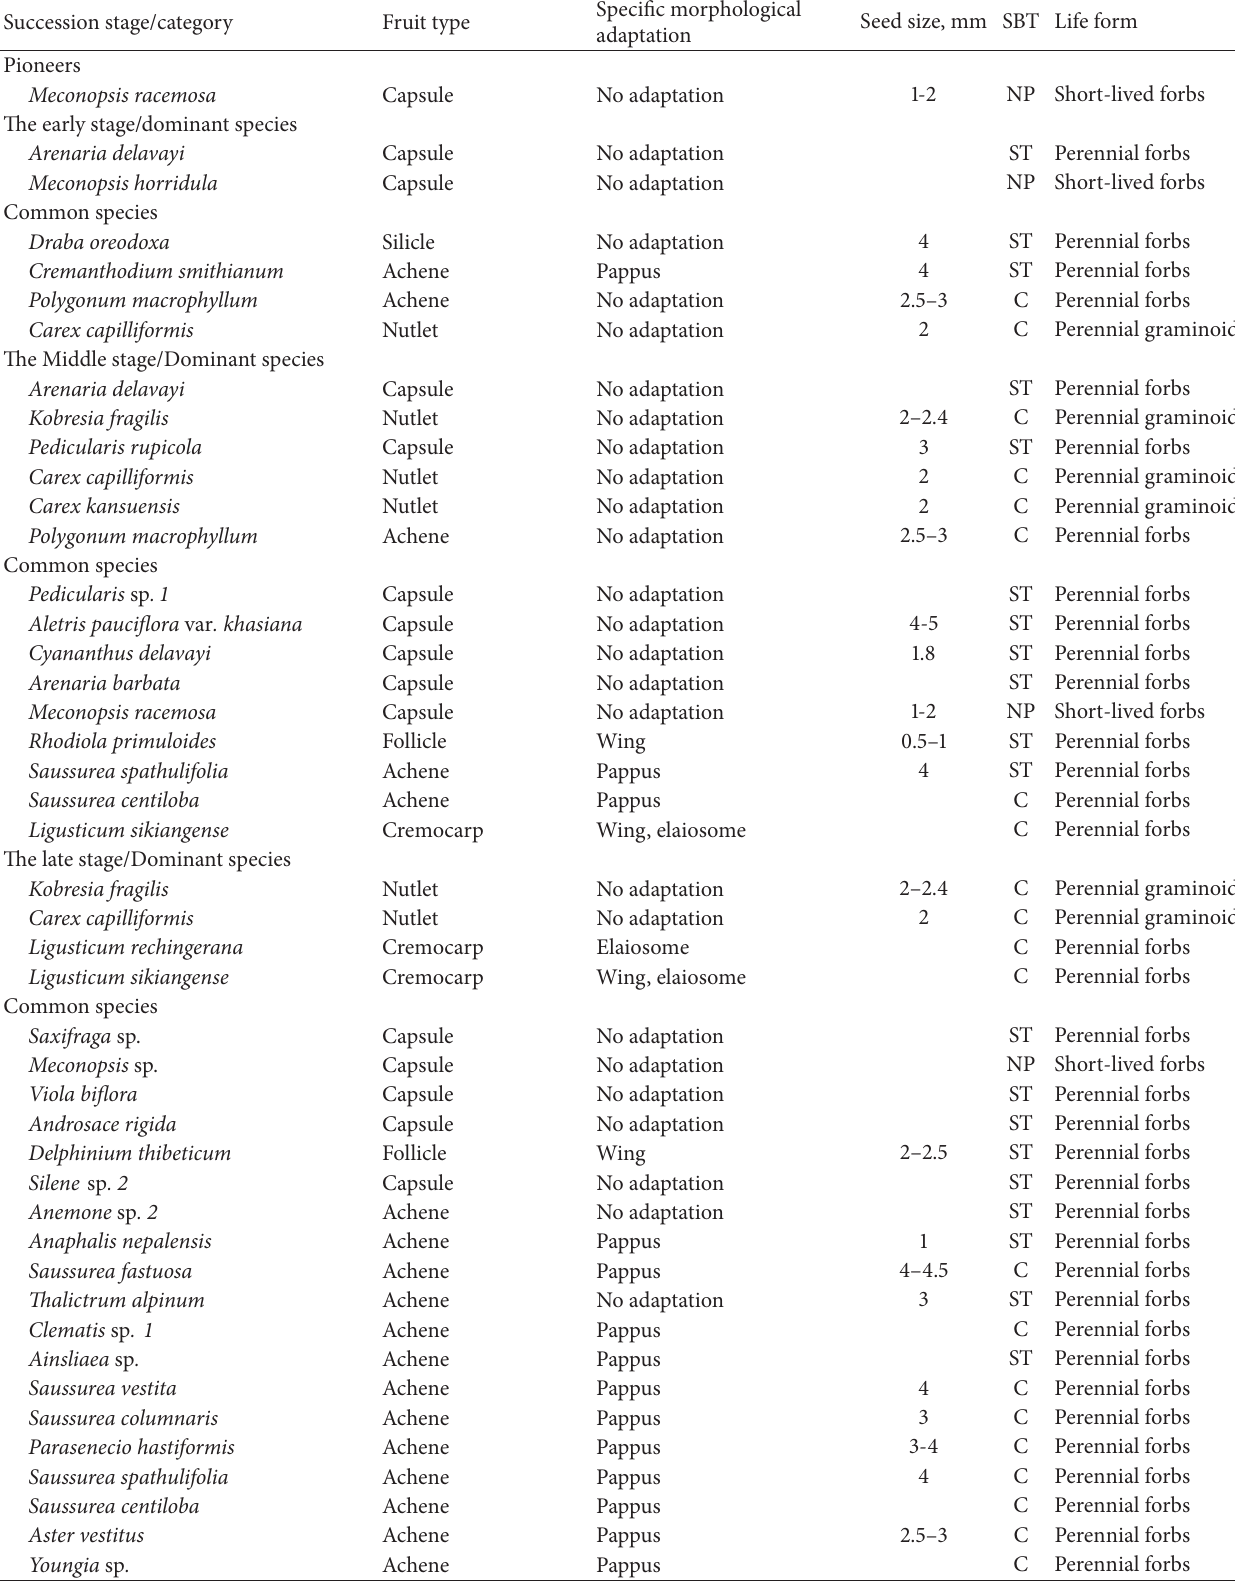
Table 4: The properties of main species diaspore on the foreland of